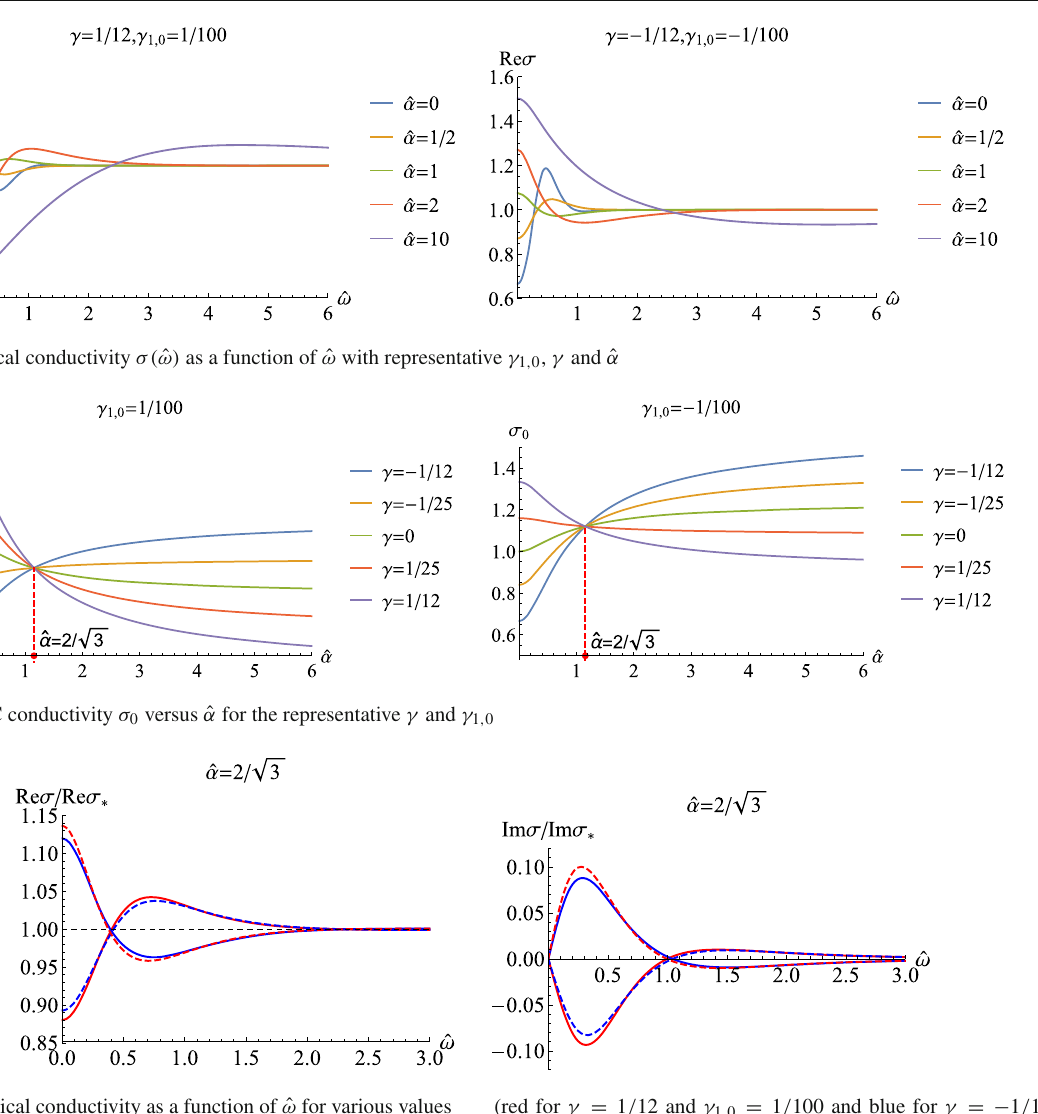
(red for γ = 1 / 12 and γ 1 , 0 = 1 / 100 and blue for γ = − 1 / 12 and γ = − 1 / 1 , 0